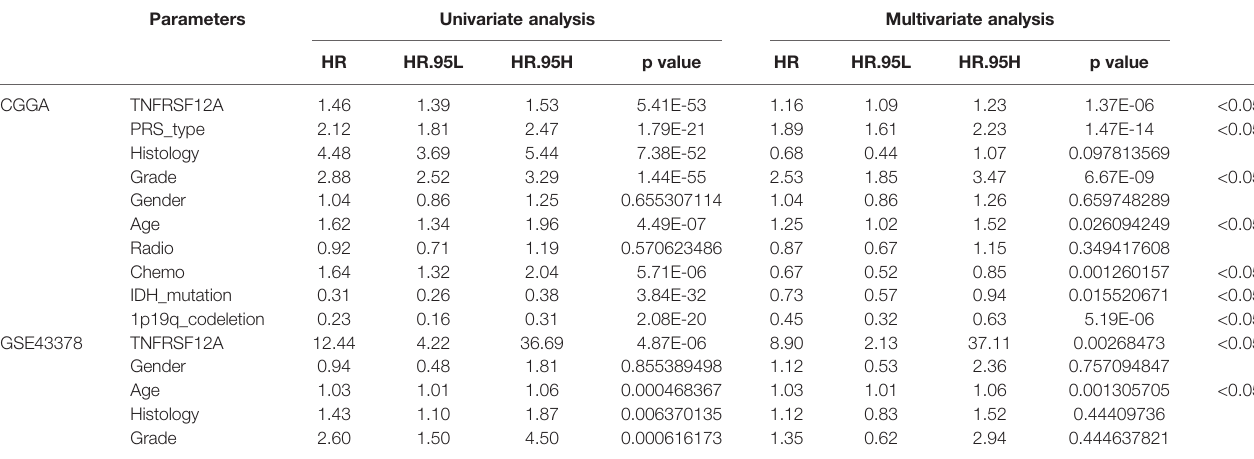
TABLE 2 | Univariate and multivariate independent prognostic analysis of glioma patients in CGGA and GSE43378. Parameters